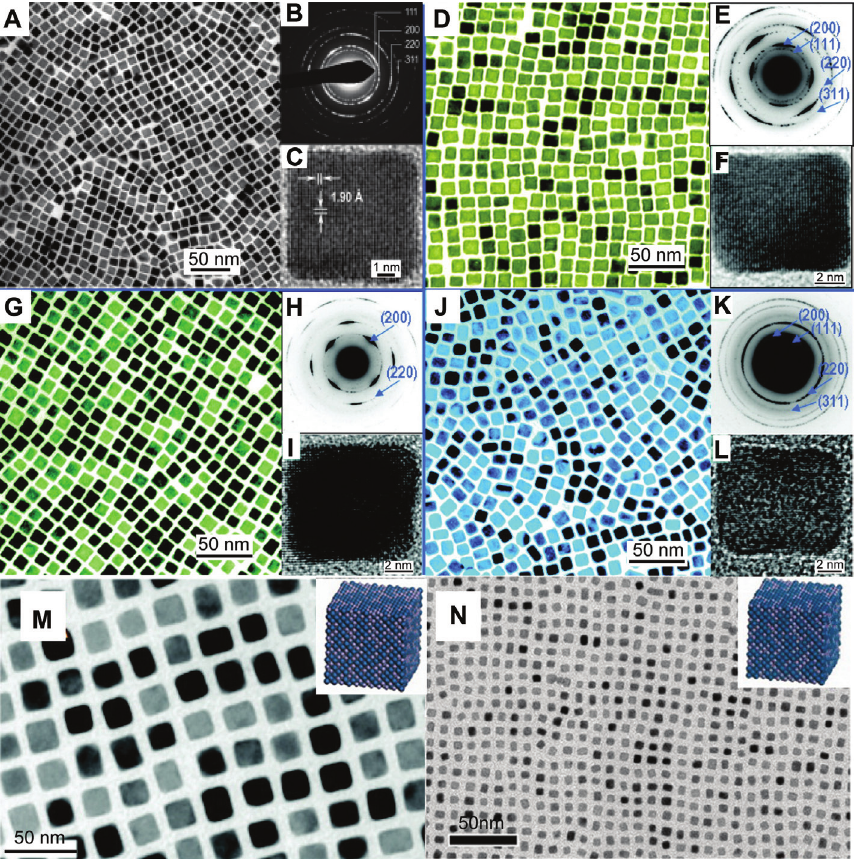
Co bimetallic and 3